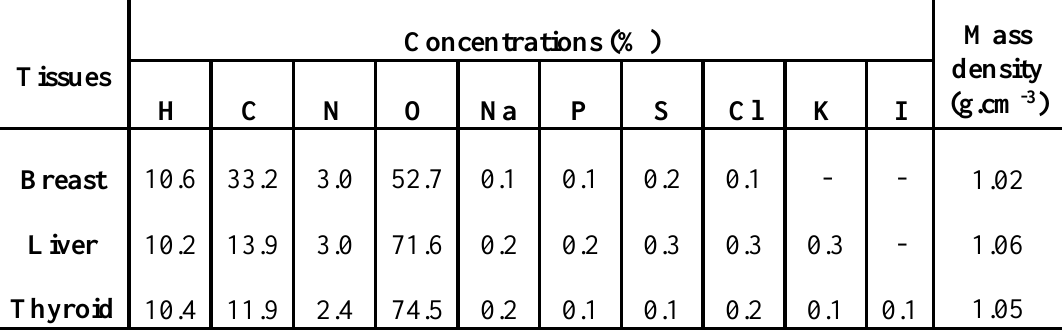
Table 1: Some human body tissues' elemental compositions and mass densities [28].